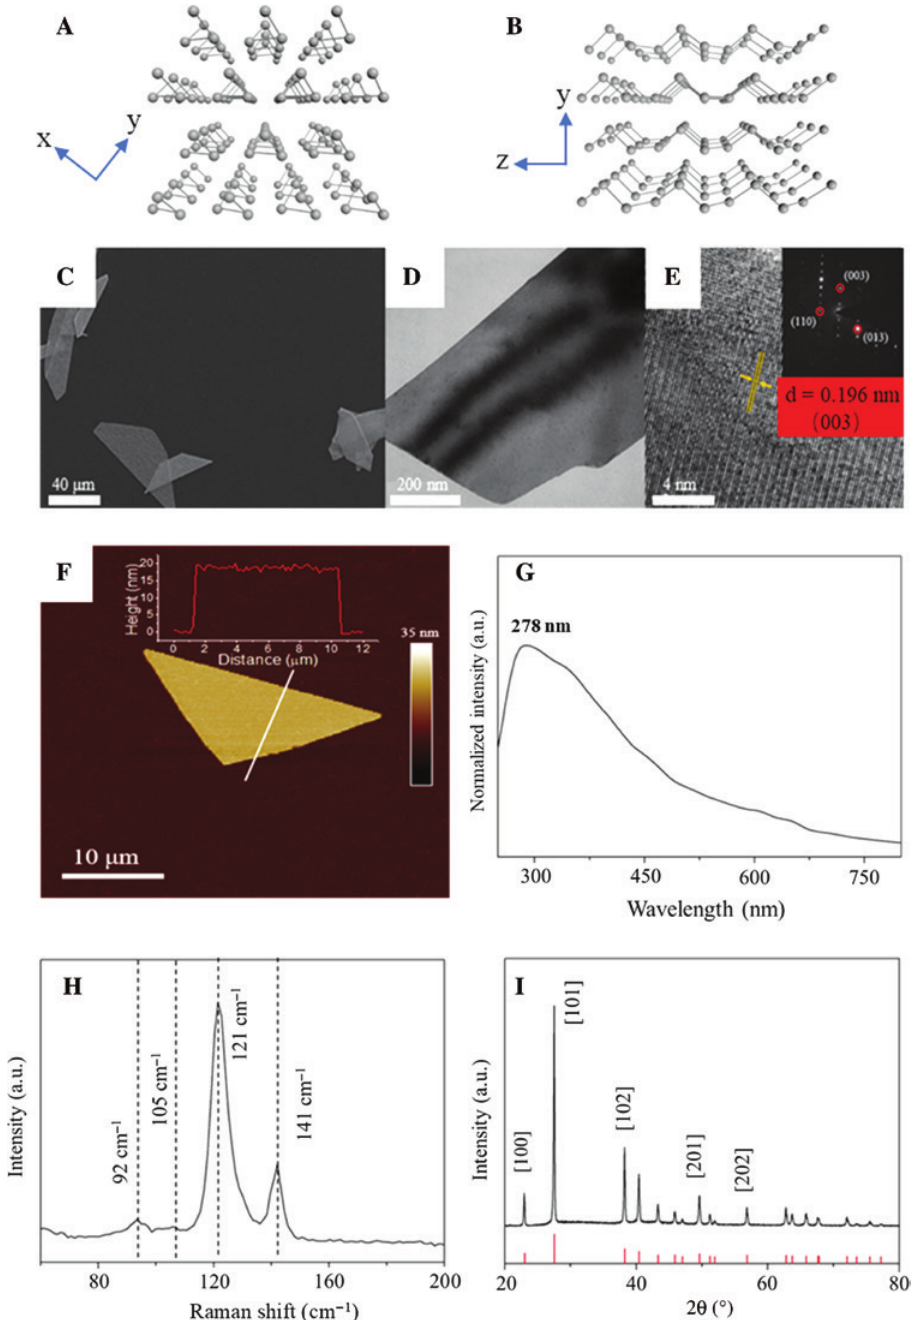
Figure 1: Crystal structure of Te viewed from the (A) x -axis and (B) z -axis. (C) SEM and (D) TEM images of Te NSs. (E) HR-TEM image and the corresponding SAED pattern of Te NSs. (F) AFM image of a typical Te NS of thickness 18.9 nm. (G–I) UV-Vis absorption, and Raman and XRD spectra of Te